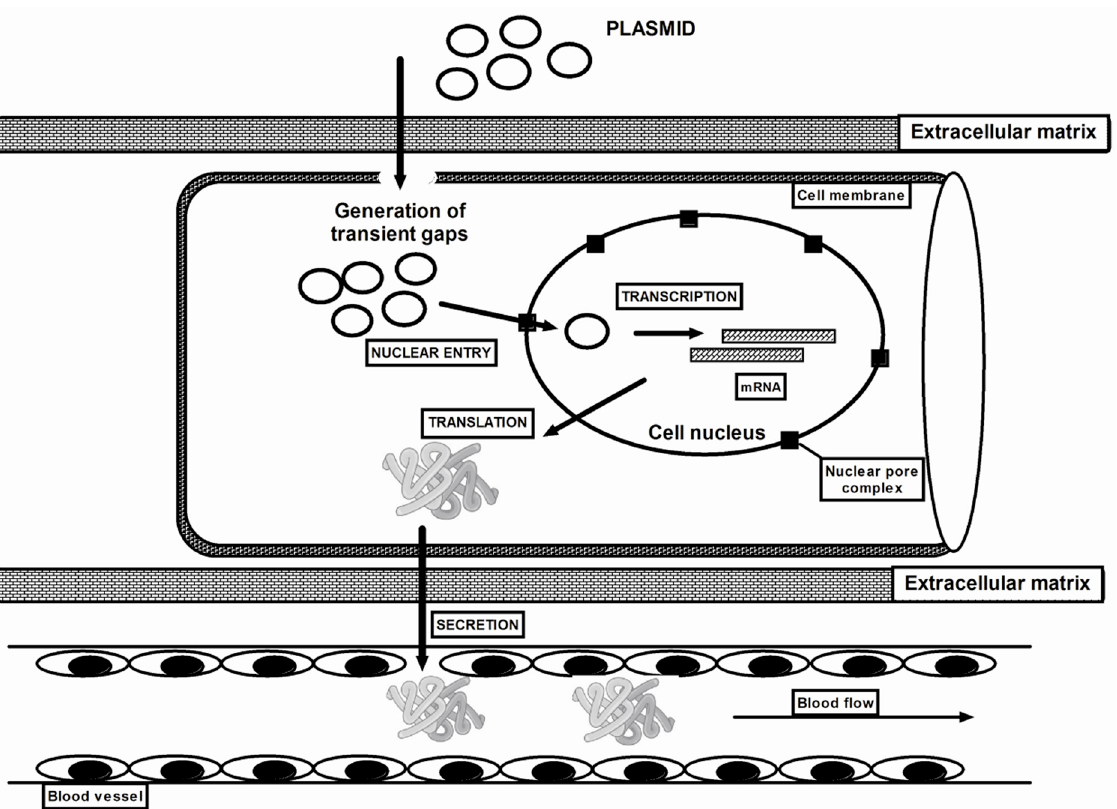
Figure 1. Schematic diagram of proposed plasmid DNA delivery with the use of electroporation. Plasmid DNA (pDNA) must overcome barriers, including extracellular matrix, cell membrane, cytoplasm and nuclear membrane before reaching the nucleus. However, applying an electric current with an appropriate voltage facilitate the transport of pDNA through biological membranes. Plasmids penetrate into the target cell cytoplasm through the transiently formed gaps in the sarcolemma. DNA in the cytoplasm is exposed to degradation by cytoplasmic nucleases. Finally, the DNA through nuclear pore complexes has to penetrate the nuclear membrane to enter the nucleus where the transcription occurs. The delivered plasmid DNA may silence genes or be transcribed into the missing protein and then secreted into the bloodstream.